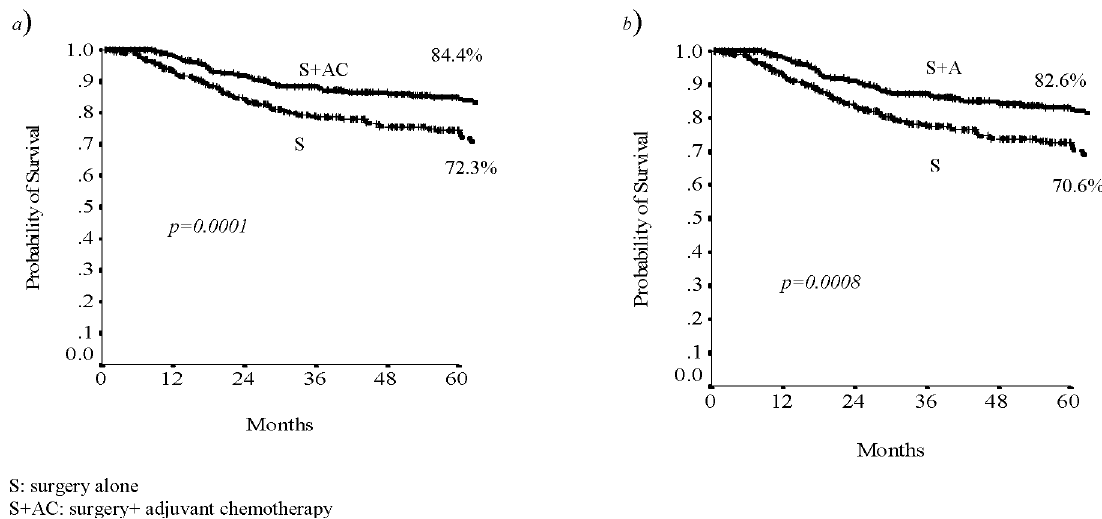
Figure 3. The 5-years overall survival curves related to treatment in low risk group.